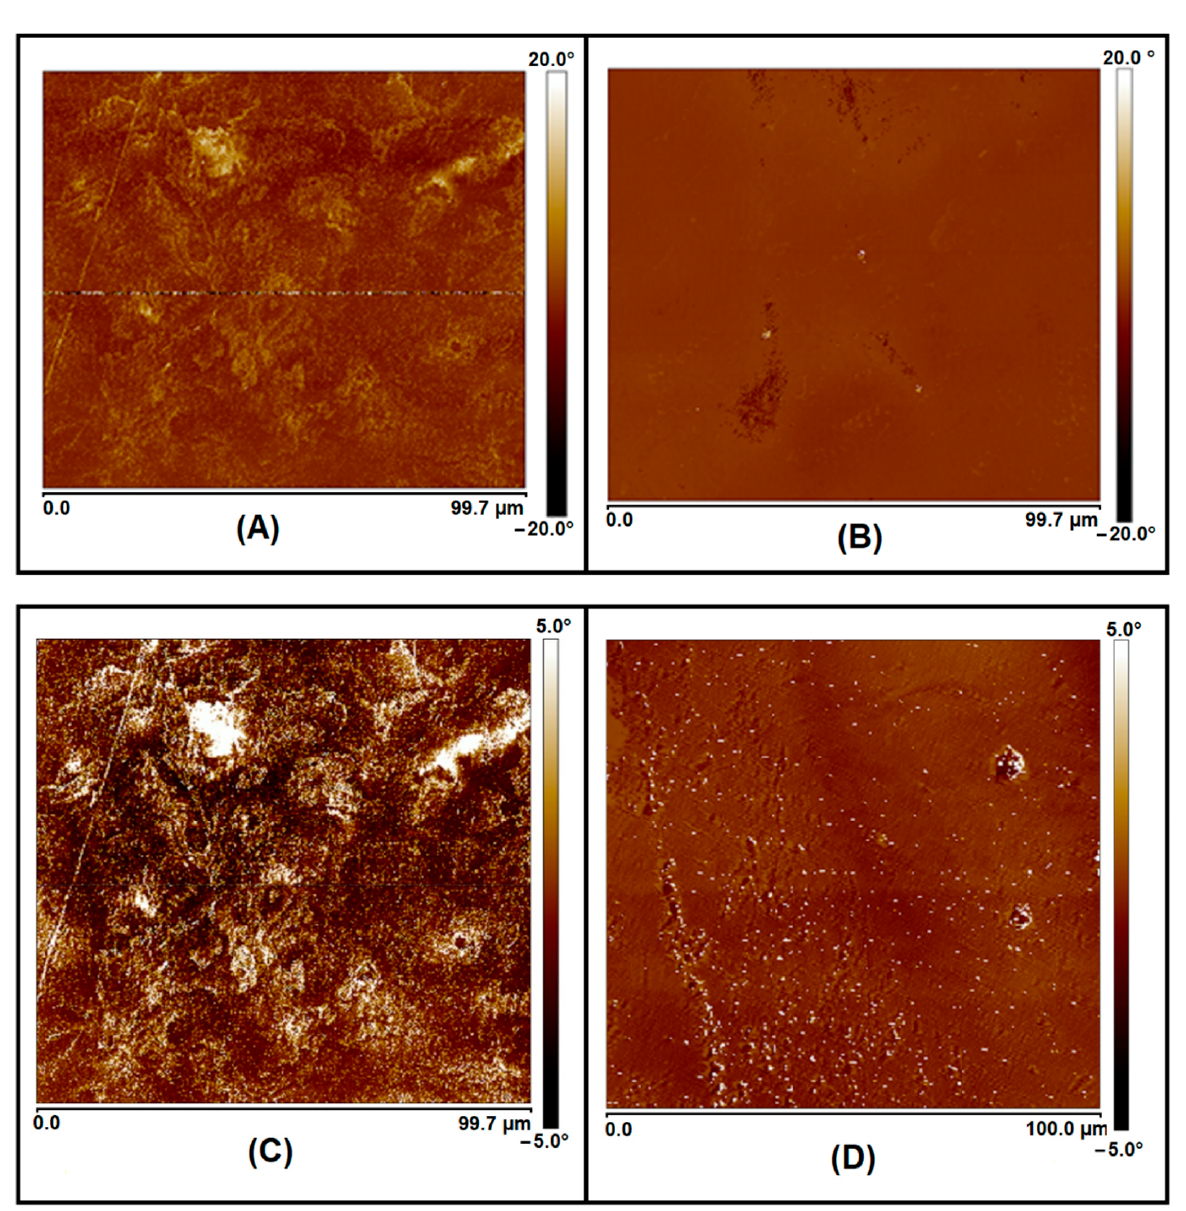
Figure 3. AFM micrographs of PHB/PCL (60/40) ( A ), PHB/PCL (60-40)-5DCP compatibilized blend ( B ), PHB/PCL (60-40)-5PEG ( C ) and PHB/PCL (60-40)-5DCP-5PEG ( D ).